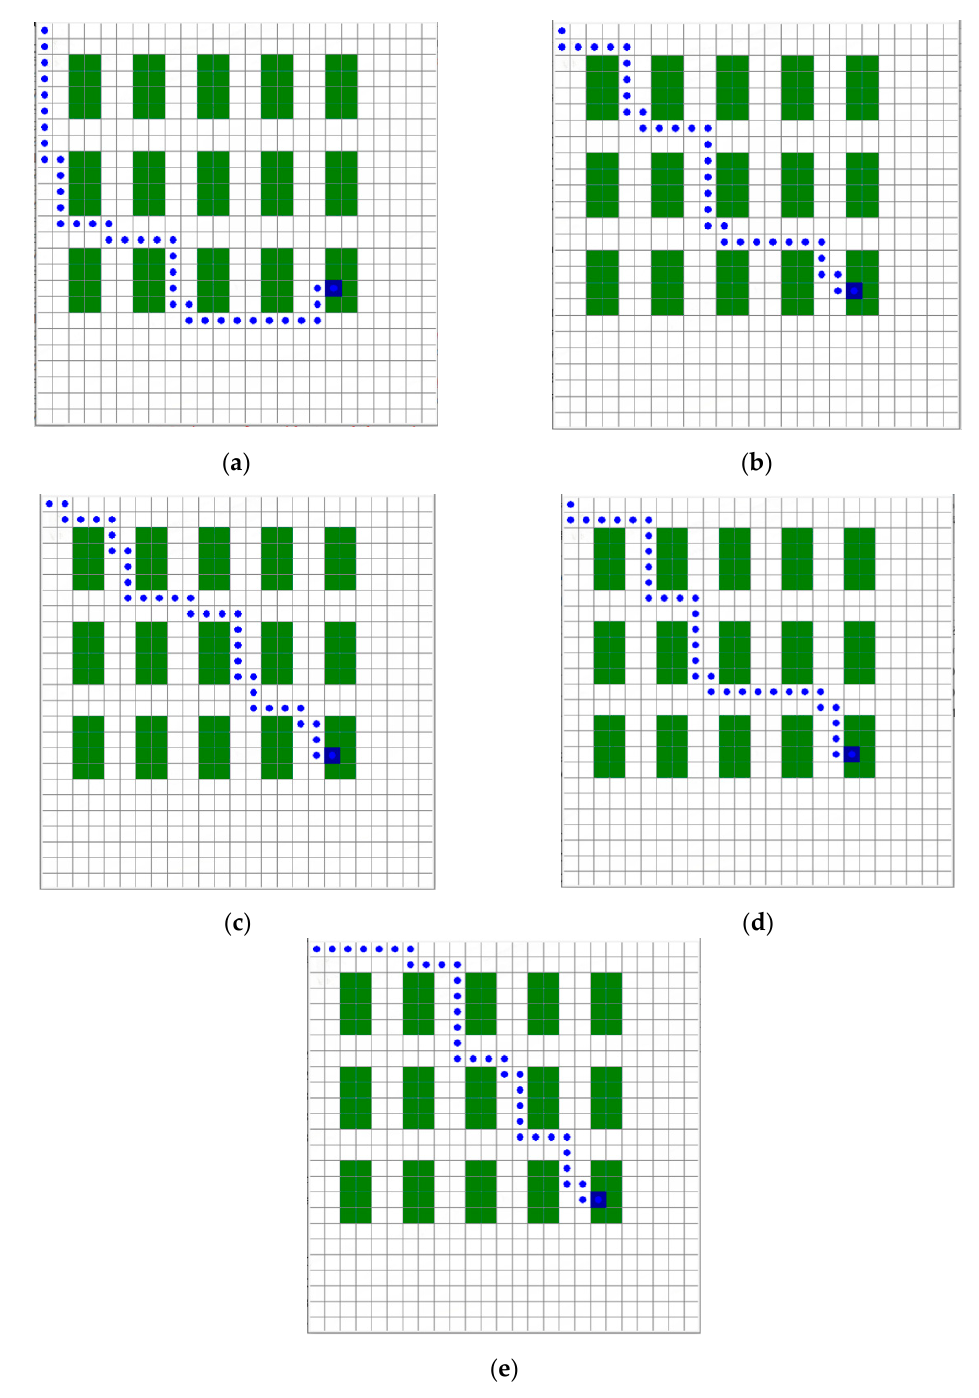
Figure 15. Path results of Q-Learning with action based reward: ( a ) 1st test; ( b ) 2nd test; ( c ) 3rd test; ( d ) 4th test; ( e ) 5th test.